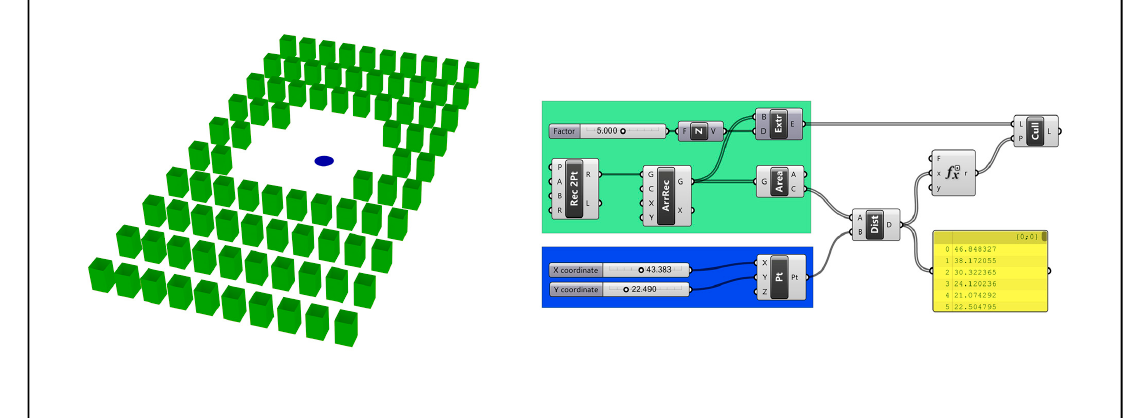
Figure 5. Attractor point.